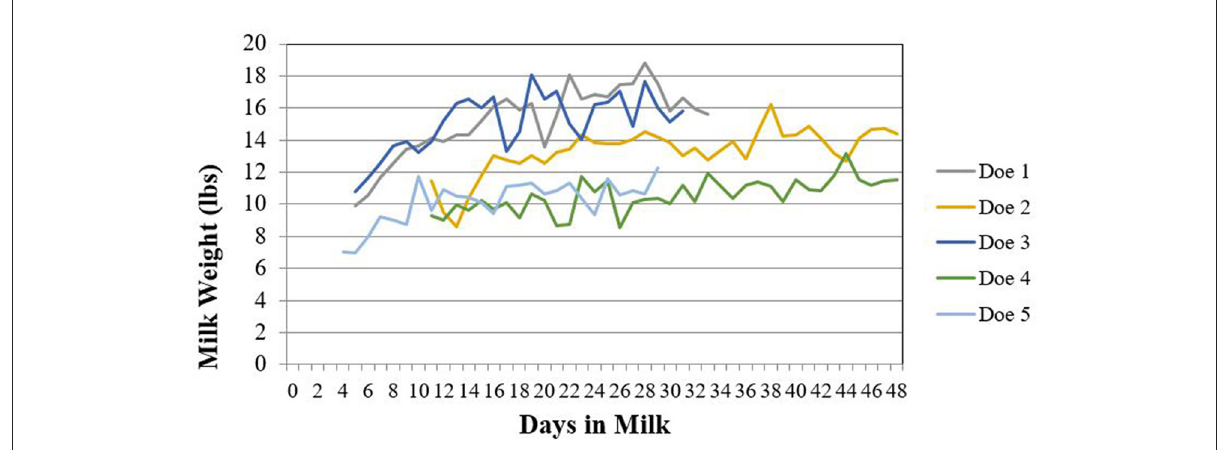
FIGURE2 Daily milk production for does ( n = 5) enrolled in a florfenicol milk residue depletion study. Milk weights were only collected while does were enrolled in the study.